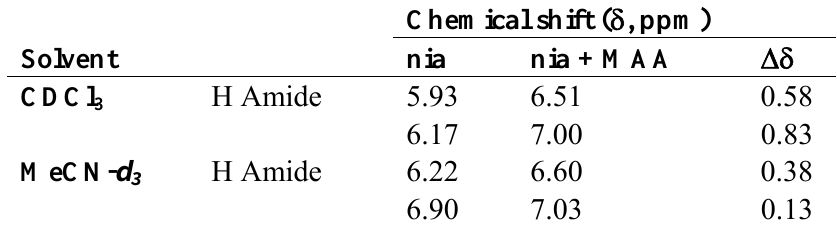
Table 2. 1 H-NMR chemical shift changes of NH MAA in CDCl or MeCN-d 3 3